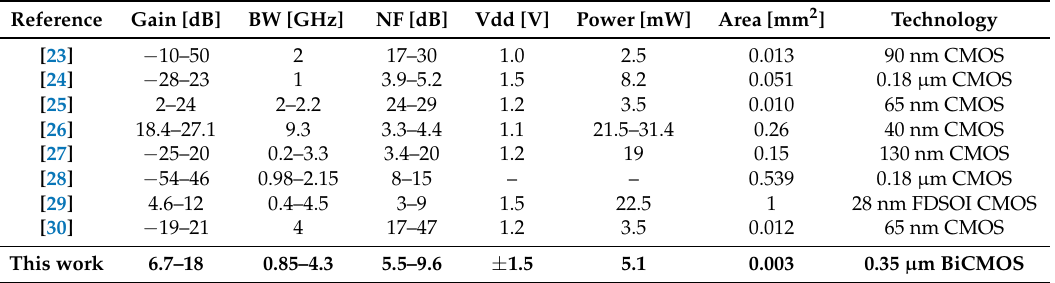
Table 2. Performance